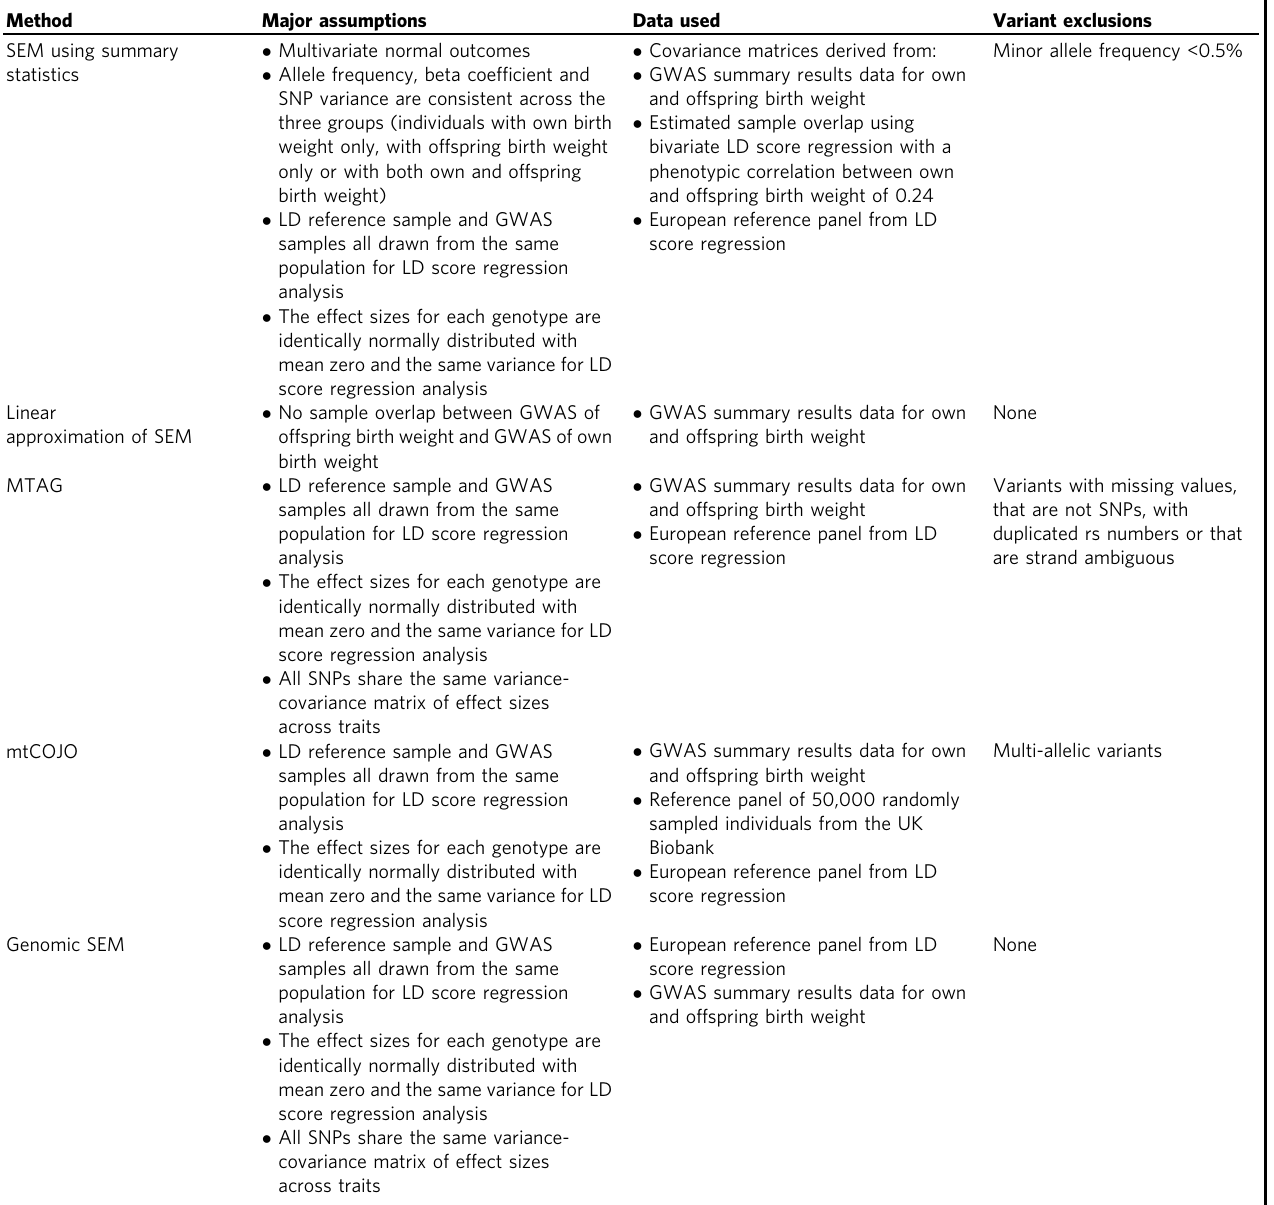
Table 1 Summary of each of the methods used to derive maternal and offspring speci fi c genetic effects using summary statistics from a GWAS of own birth weight and a GWAS of offspring birth